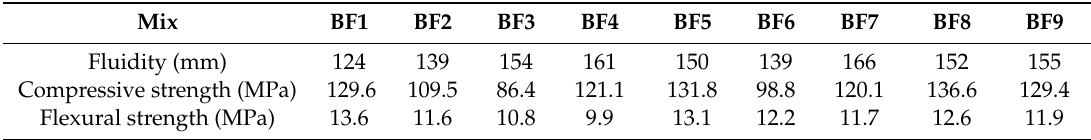
Table 5. Mechanical properties of the studied BFRPC.